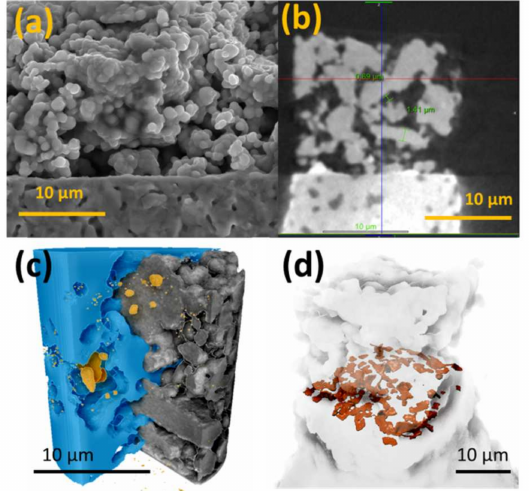
Figure 3. ( a ) Back-scattered electron (BSE) and ( b ) Ultra 3D X-ray microscopy (XRM) images of the cross-section of a LCFCr/GDC interface of an as-prepared cell. ( c ) Porosity visualization of the 32 nm/voxel Ultra 3D XRM image where the LCFCr phase is shown in grey, the connected porosity in blue, and the unconnected porosity in orange. ( d ) Visualization of the interfacial contact area (orange) between the LCFCr and GDC phases as determined by the Ultra 3D XRM